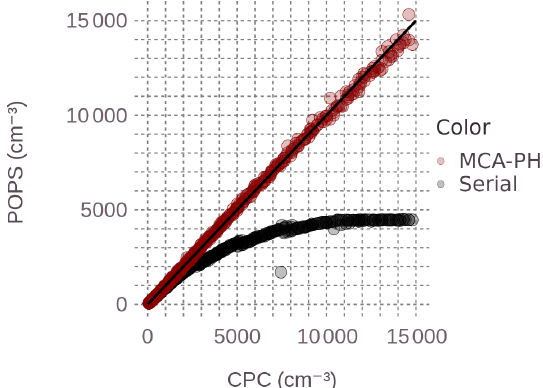
Figure 6. Relationship between CPC number concentration and POPS number concentration derived from the serial and MCA-PH distributions. The solid black line corresponds to the 1 : 1 relation-